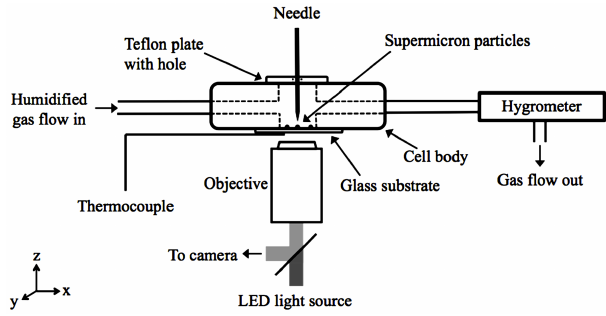
Figure 1. Schematic representation of poke-and-flow experimental